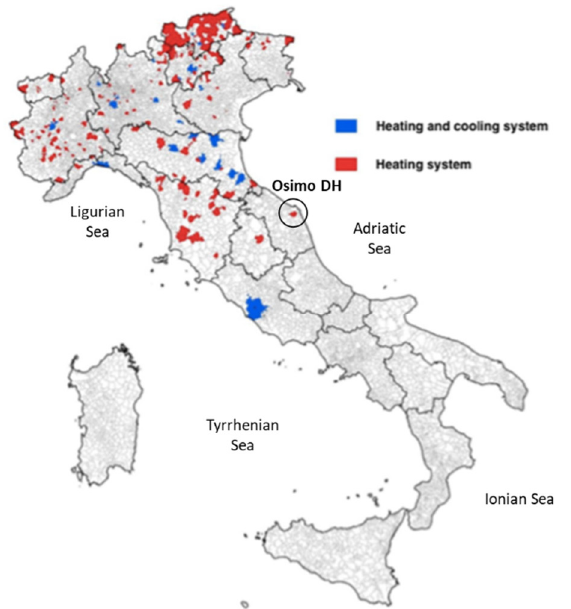
Figure 1. Heating and cooling systems in Italy, in which the Osimo DH network has been high-